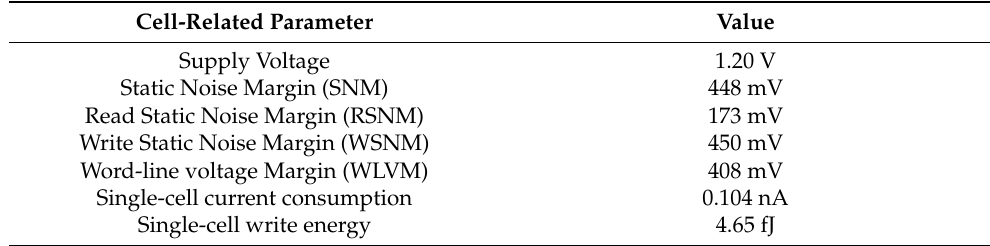
Table 1. Cell-related parameters of interest.